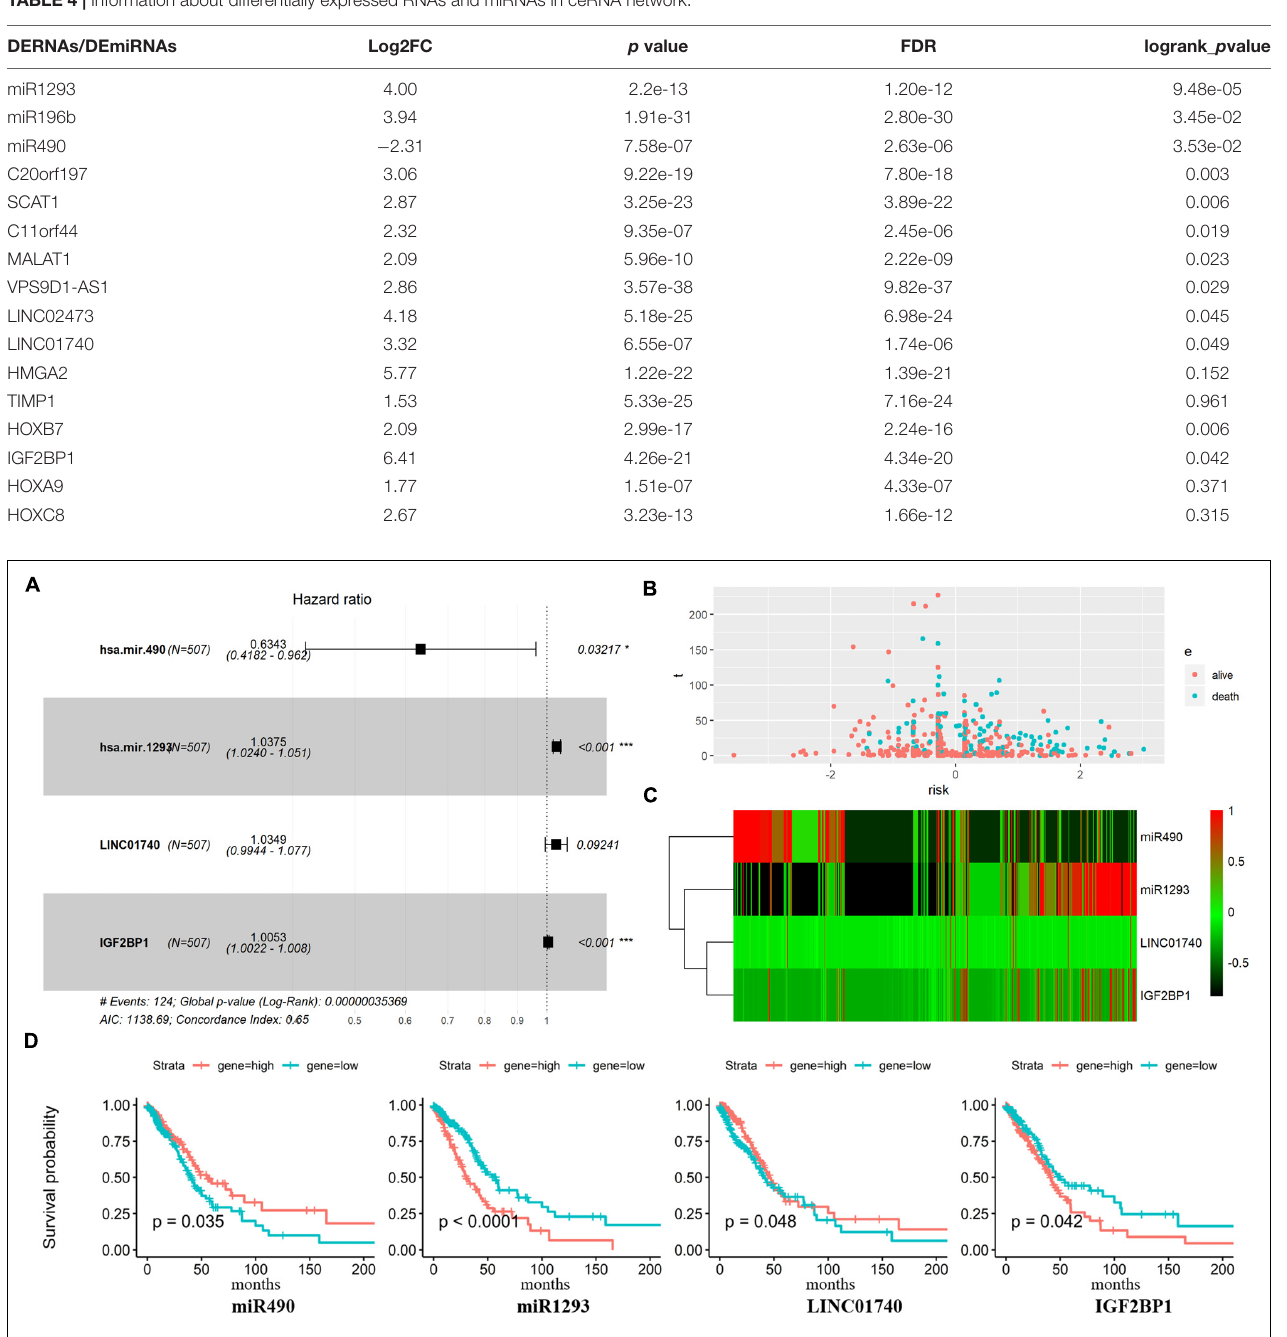
FIGURE 5 | Predictive gene signature analysis. (A) Forest map based on the risk score model. Left vertical dotted line indicates protective genes and right risk genes. (B) The scatter diagram based on survival time and log2(risk score). The red means alive and green means death. The higher log2(risk score) is, the shorter the time survival. (C) Differentially expressed predictive genes that were enrolled in the risk model heatmap. (D) Overall survival curves of four predictive genes in